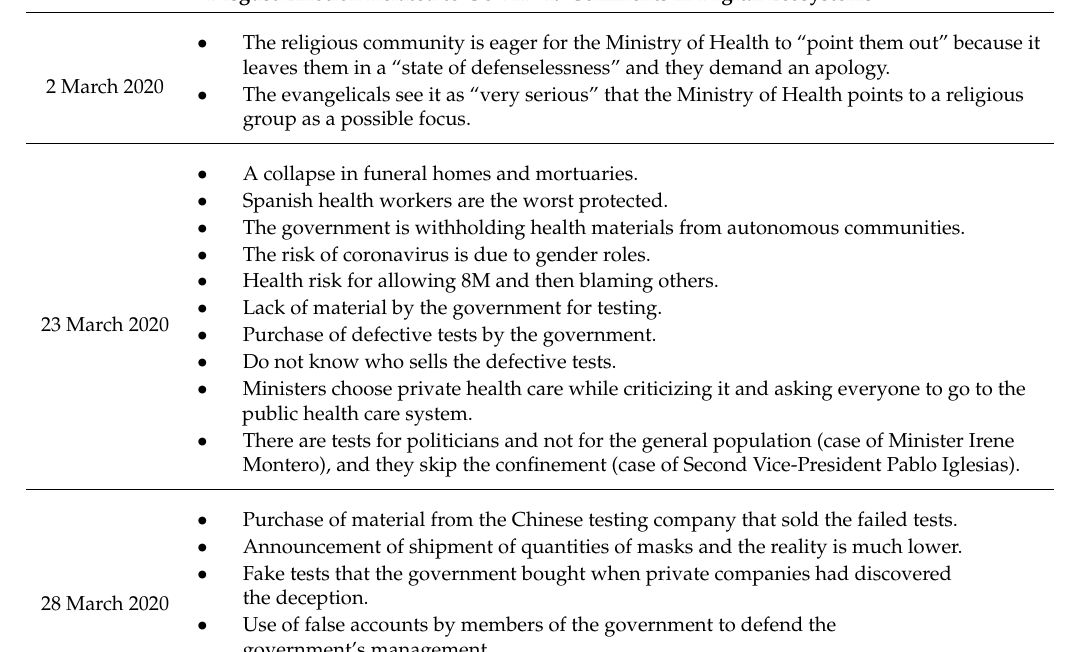
Table 1. Comments related to Disgust emotion and COVID-19 in digital ecosystems. Disgust Emotion Related to COVID-19 Comments in Digital